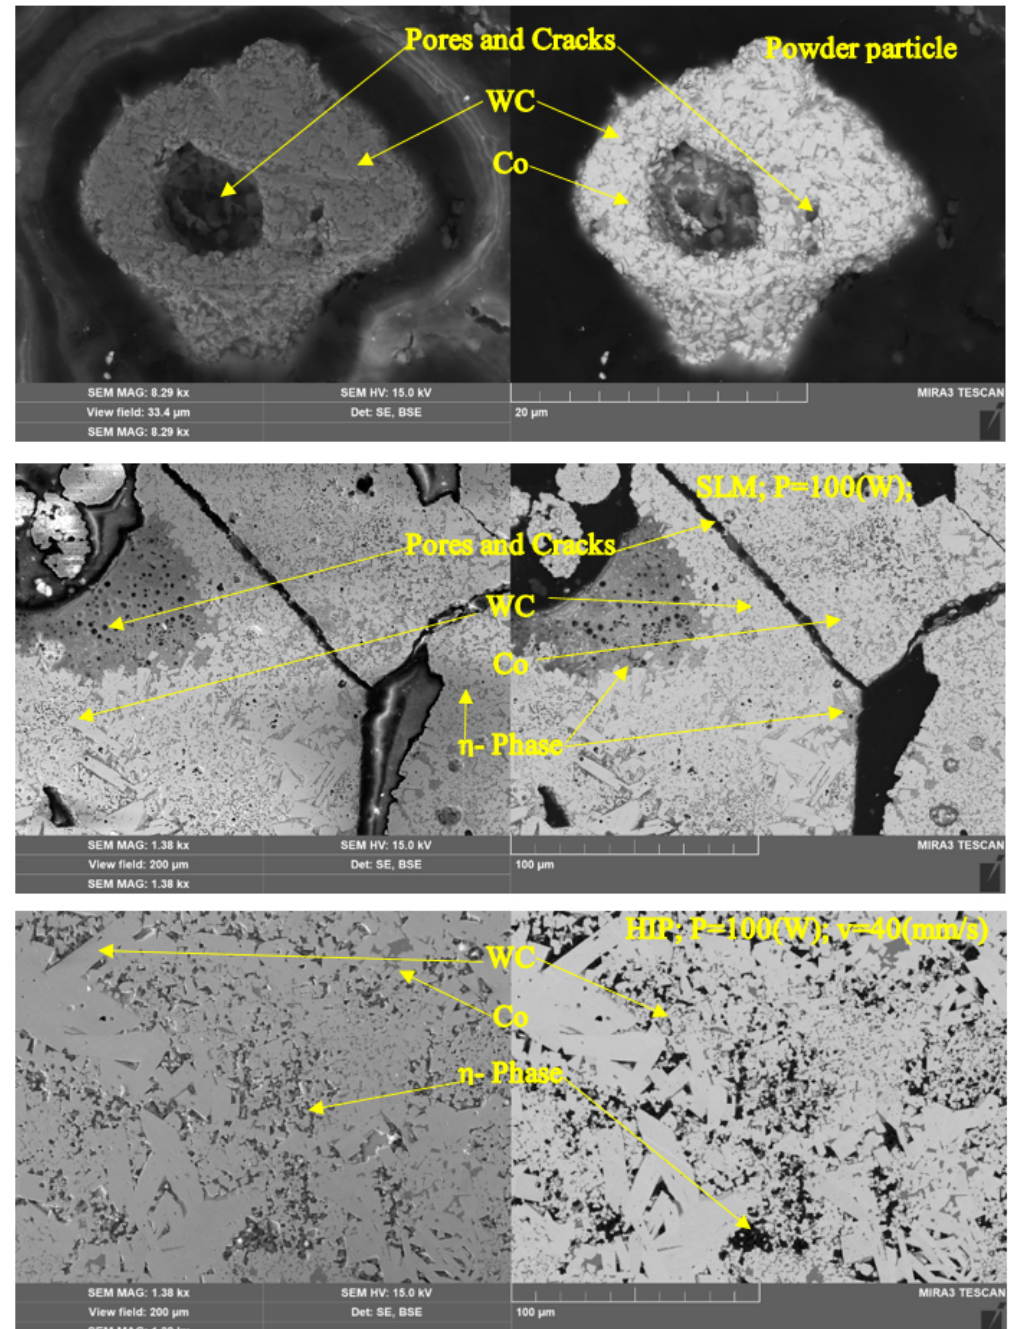
Figure 12. Microstructures produced by SLM and HIP processing. The top micrograph shows the microstructure of a virgin powder particle. The middle one shows the microstructure after SLM. The post-HIP microstructure is shown in the bottom